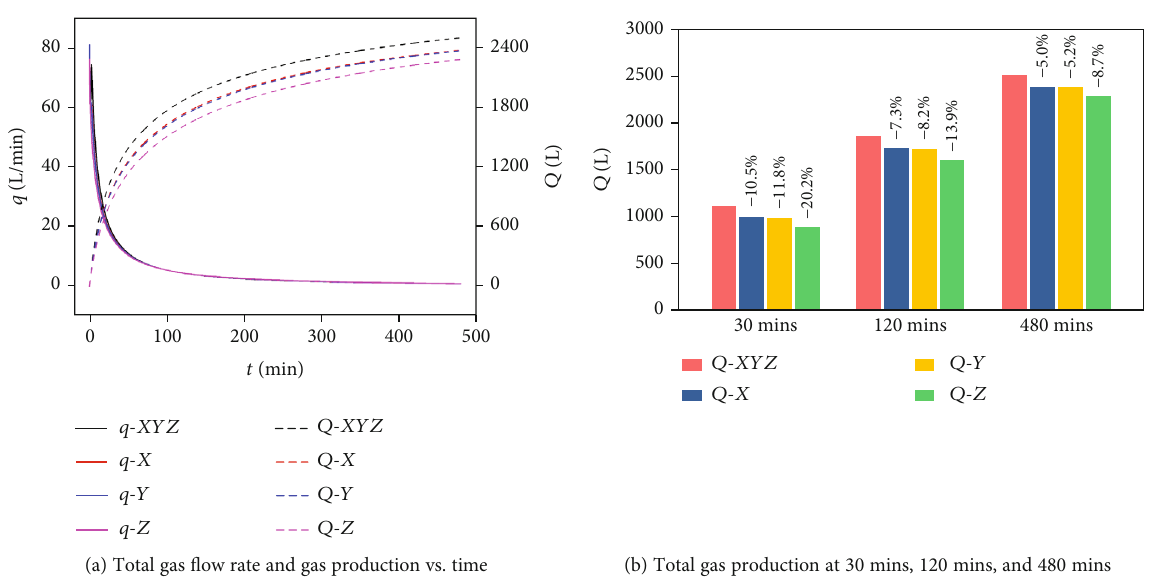
Figure 8: Total gas fl ow rate and gas production under di ff erent unloading stress